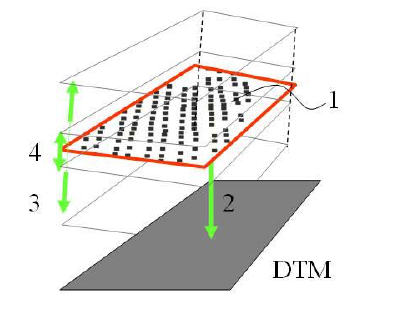
Figure 1 Four geometric parameters in a schematic representa- tion: NP (1), D2DTM (2), NUSPR in range between 0.2-1.0 m from plane (3), planarity of segment within 0-0.2 m (4).